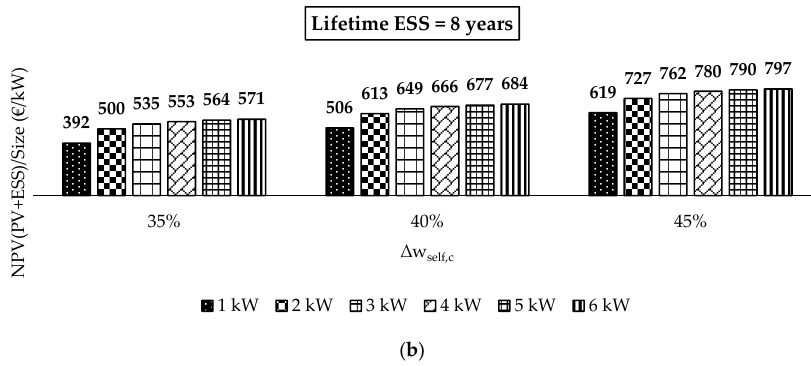
Figure 3. Net Present Value (PV + ESS)/Size ( € /kW) with B/S equal to 2.0. ( a ) is expressed in € /kW with B/S equal to 2.0 and lifetime EES equal to six years; ( b ) is expressed in € /kW with B/S equal to 2.0 and lifetime EES equal to 8 years.